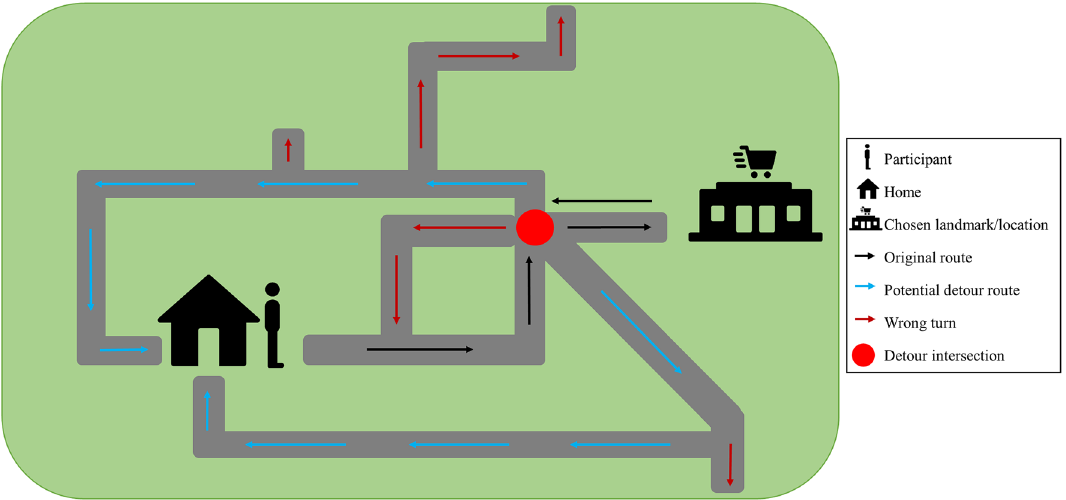
Figure 3. Illustration of the DNT. Participants navigate to a chosen landmark/location in their neighbourhood that they commonly visit using their usual route (i.e., original route); this route entails participants to predominantly use an egocentric navigation strategy. Once at the destination, participants are asked to navigate back home using the same route. Unknown to them, at the first intersection on the way back, they are asked to find an alternative route back home which does not overlap with the original route (i.e., detour route); this requires participants to utilise their cognitive maps of their neighbourhood to navigate, and hence entails the use of an allocentric navigation strategy. Adapted from 59 . Icons used in the figure – “Person” by Irene